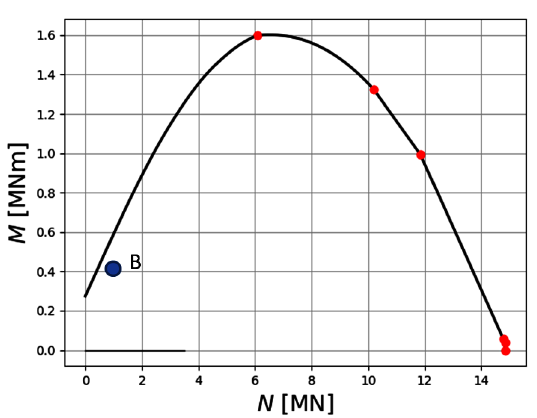
Figure 8: Checking the ULS condition at any point of the structure by projecting the stress resultant pairs on the domain bound by the MN − interaction diagram.